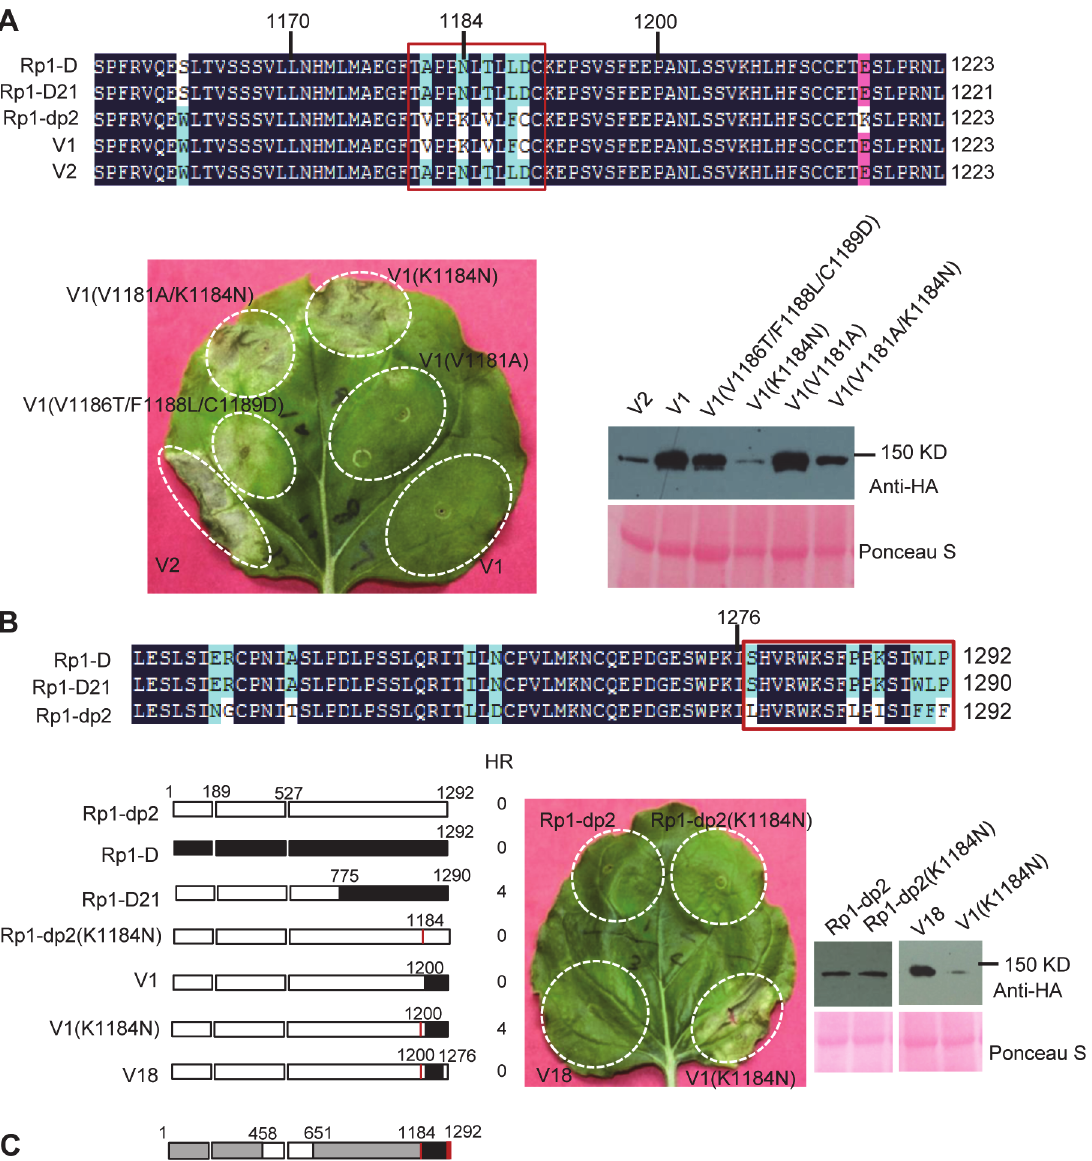
Fig 7. Investigating the functional regions of amino acids (AAs) from 1170 – 1200 and the C-terminal end of Rp1-D21. (A) Investigating the point mutations in the region of AAs 1170 – 1200 which are important for inducing hypersensitive response (HR). Top: Multiple sequence alignment of Rp1-D, Rp1- D21, Rp1-dp2, V1 and V2. The black, red and light blue shaded regions represent 100%, 75% and above 50% similarity of the amino acids, respectively. The polymorphic amino acids are boxed, and the position of 1184 (corresponding to 1182 of Rp1-D21) is labeled above the sequences. Bottom left: The HR phenotype of V1, V2 and V1-derived point mutants as indicated. A representative leaf was photographed at 3 days post infiltration (dpi). Bottom right: Total protein was extracted from agro-infiltrated leaves at 30 hours post infiltration (hpi), and anti-HA antibody was used to detect the expression of the fused proteins. Equal loading of protein samples was shown by Ponceau-S staining of Rubisco subunit. (B) Investigating the phenotype conferred by various recombinants and point mutants at the C-terminal end of Rp1-D21. Top: Multiple sequence alignment of the C-terminus of Rp1-D, Rp1-D21 and Rp1-dp2. The polymorphic amino acids are boxed. Bottom left: Schematic diagram of the constructs used. The K1184N mutation is indicated by a red vertical bar in Rp1-dp2(K1184N), V1(K1184N) and V18. Bottom middle: The HR phenotype of the constructs transiently expressed in N . benthamiana . A representative leaf was photographed at 3 dpi. Bottom right: Total protein was extracted from agro-infiltrated leaves at 30 hpi, and anti-HA antibody was used to detect the expression of the fused proteins. Equal loading of protein samples was shown by Ponceau-S staining of Rubisco subunit. The experiments were repeated three times with the same results. (C) The final model presenting the functional regions important for autoactivity. In this model, white represents regions derived from Rp1-dp2 and black the region from Rp1-D that need to be present in the same construct to result in the autoactive HR in N . benthamiana . Regions in grey can be derived from either paralog. The combination of AA 458 – 651 from Rp1-dp2 and AA 1184 – 1292 (especially N1184 and the last 16 AAs in red vertical bars) from Rp1-D are important for HR induction.